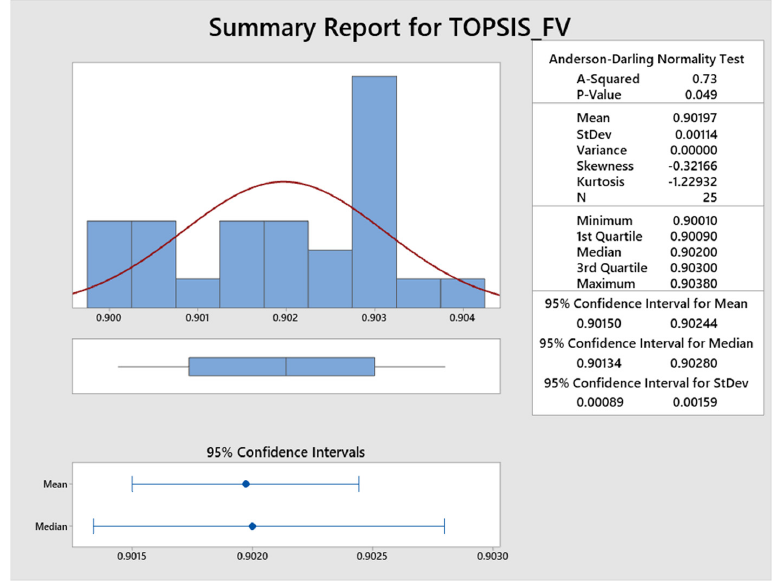
Figure 8. Statistical analysis of 25 runs.